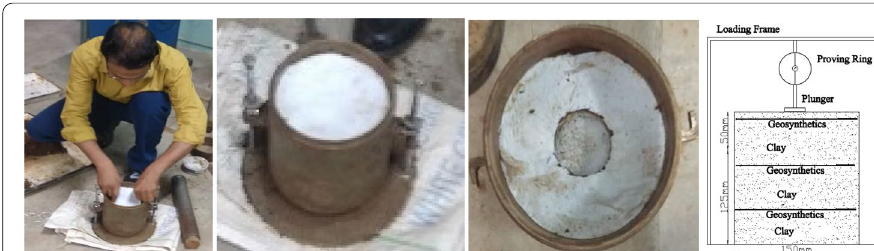
Fig. 4 Position of the geotextiles in CBR mould